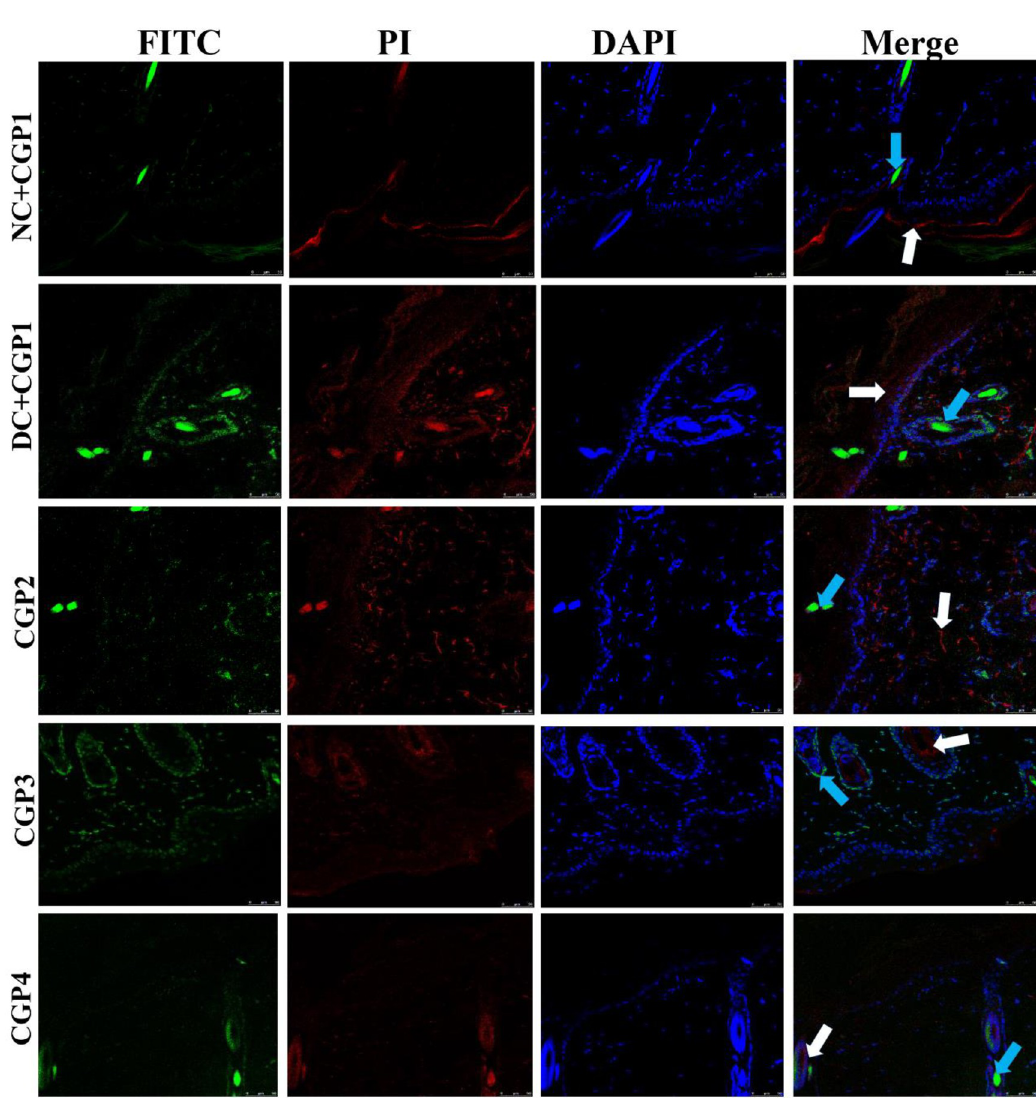
Fig 8. Effect of GC-AgNP CGPs dressing on caspase-3 and caspase-9 in diabetic rats. Immunofluorescence double staining images showing co-localization of caspase-3 (red) and caspase-9 (green). White arrows point towards the distribution of caspase-3 protein and blue arrow point towards the distribution of caspase-9. NC+CGP1: Normal control dressed with blank cotton gauze; DC+CGP1: Diabetic control rats dressed with blank cotton gauze; CGP2: Diabetic rats dressed with 13.06 μ M gallocatechin and silver nanoparticle (GC-AgNP) impregnated cotton gauze patches (DC+ 13.06 μ M CGP2); CGP3: Diabetic rats dressed with 26.12 μ M gallocatechin and silver nanoparticle (GC-AgNP) impregnated cotton gauze patches (DC+ 26.12 μ M CGP3). CGP4: Diabetic rats dressed with silver sulfadiazine (DC+AgS) impregnated cotton gauze patches. Data were expressed as mean ± S.E.M (n = 6). Scale bar = 100 μ m.